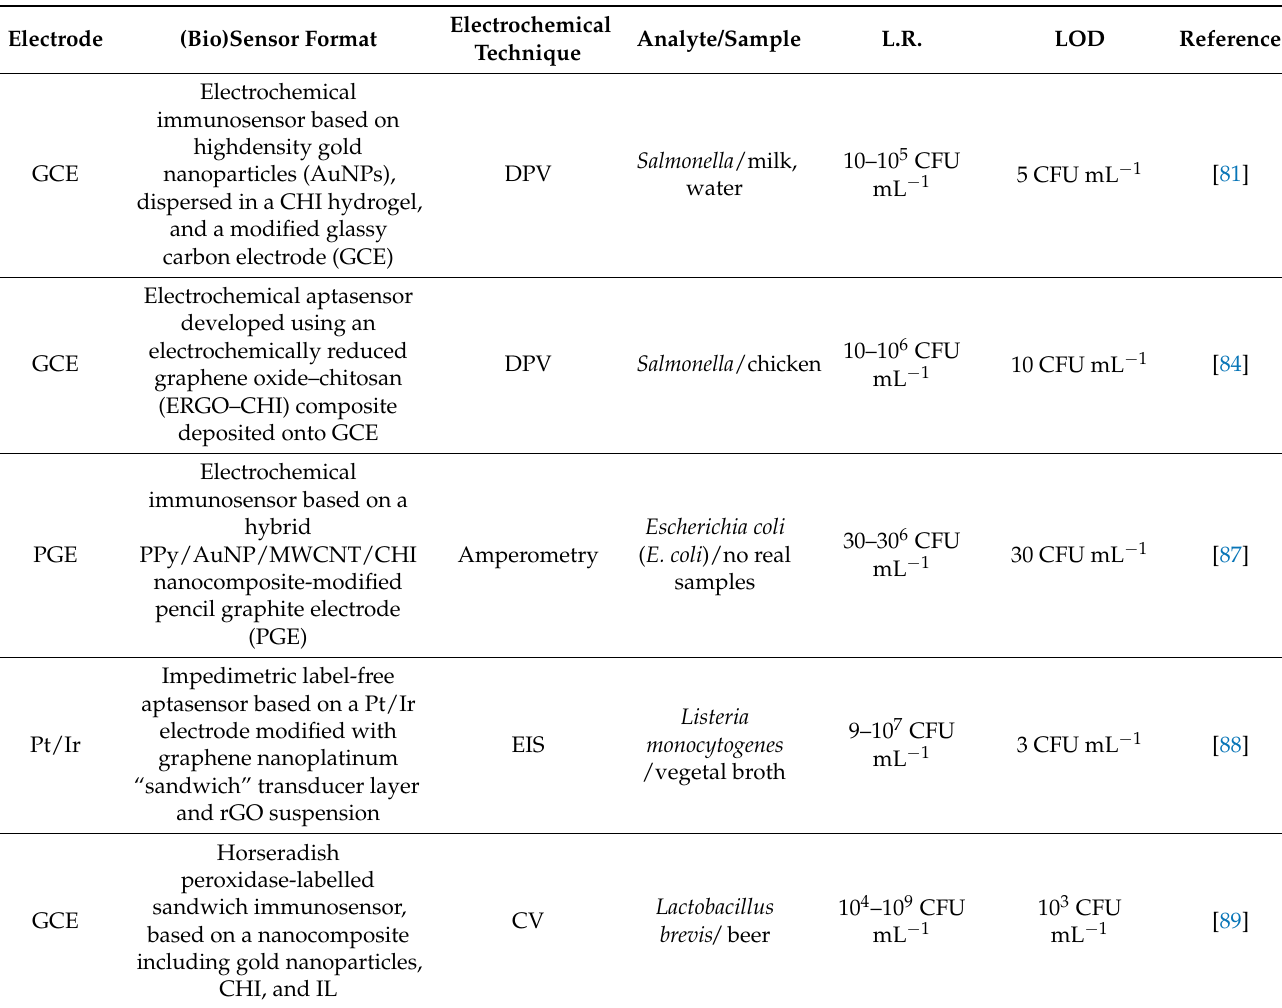
Table 3. Recent examples of CHI-based electrochemical (bio)sensors for pathogenic bacteria detection.